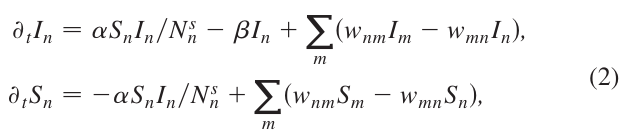
FIG. 1. Metapopulational mobility models. Patches and arrows represent individual populations and travel. (a) Diffusive dis- persal: indistinguishable individuals travel randomly between different locations governed by the set of transition rates ! nm . (b) Dispersal capturing individual mobility patterns: individuals with label k possess travel rates ! k mk and ! k km at which they travel from their base location k to connected locations m and